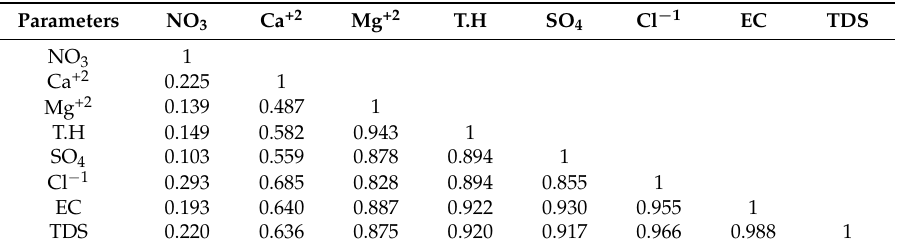
Table 3. Correlation matrix among water quality